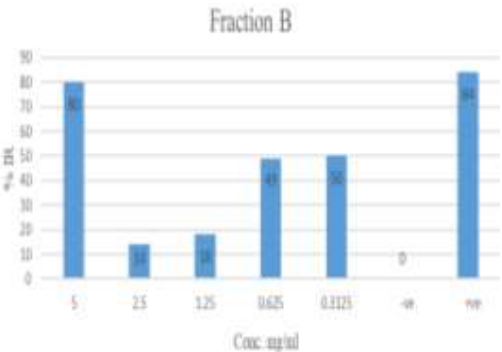
Figure 7. %IR for aerial hot petroleum ether fraction (B) dilutions (S\G\PE)